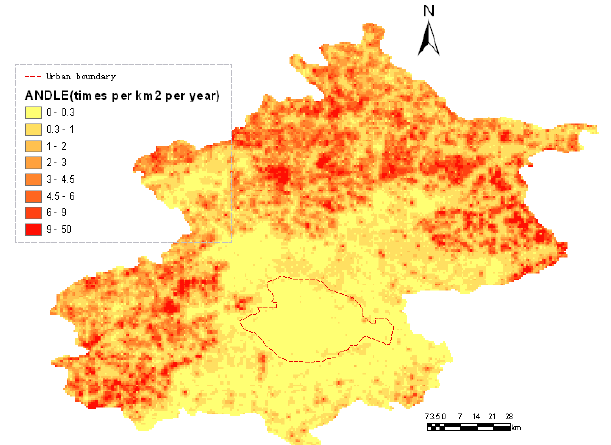
Figure 8. ANDLE zoning simulated by the model.